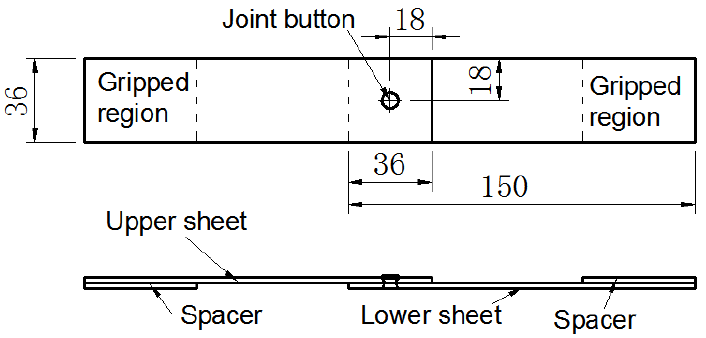
Figure 2. The size of the lap-shear SPR joint (Unit: mm).